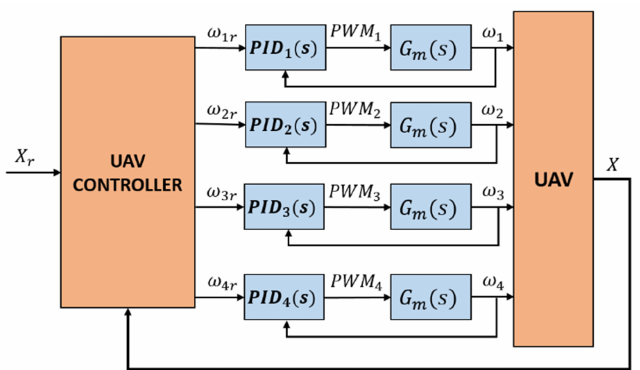
Figure 8. Overall proposed control scheme. Two control loops are depicted: the inner loop for the actuators and the outer loop for the